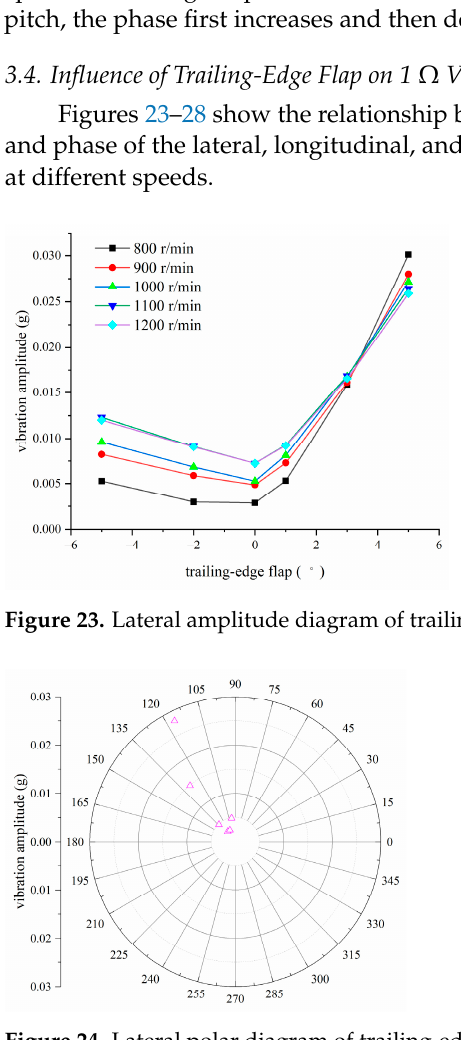
Figure 24. Lateral polar diagram of trailing-edge flap.